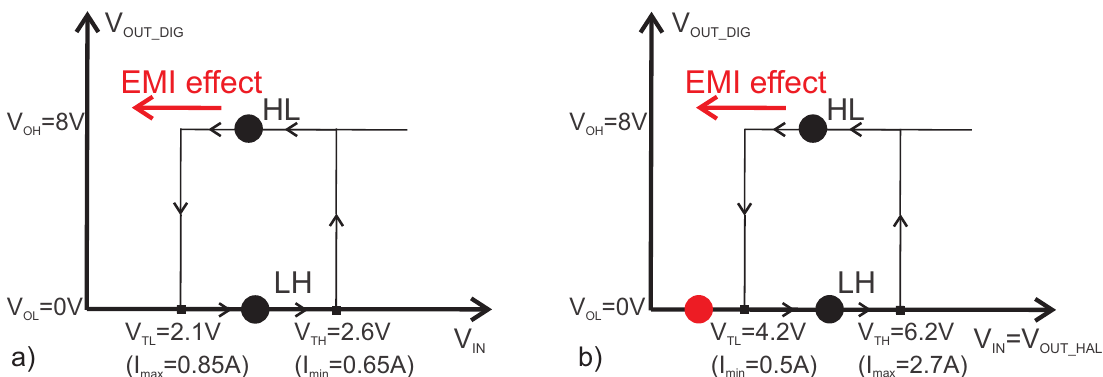
Figure 4. Hysteresis window of the output comparator for: ( a ) resistive current sensing; and ( b ) the Hall-effect sensor.